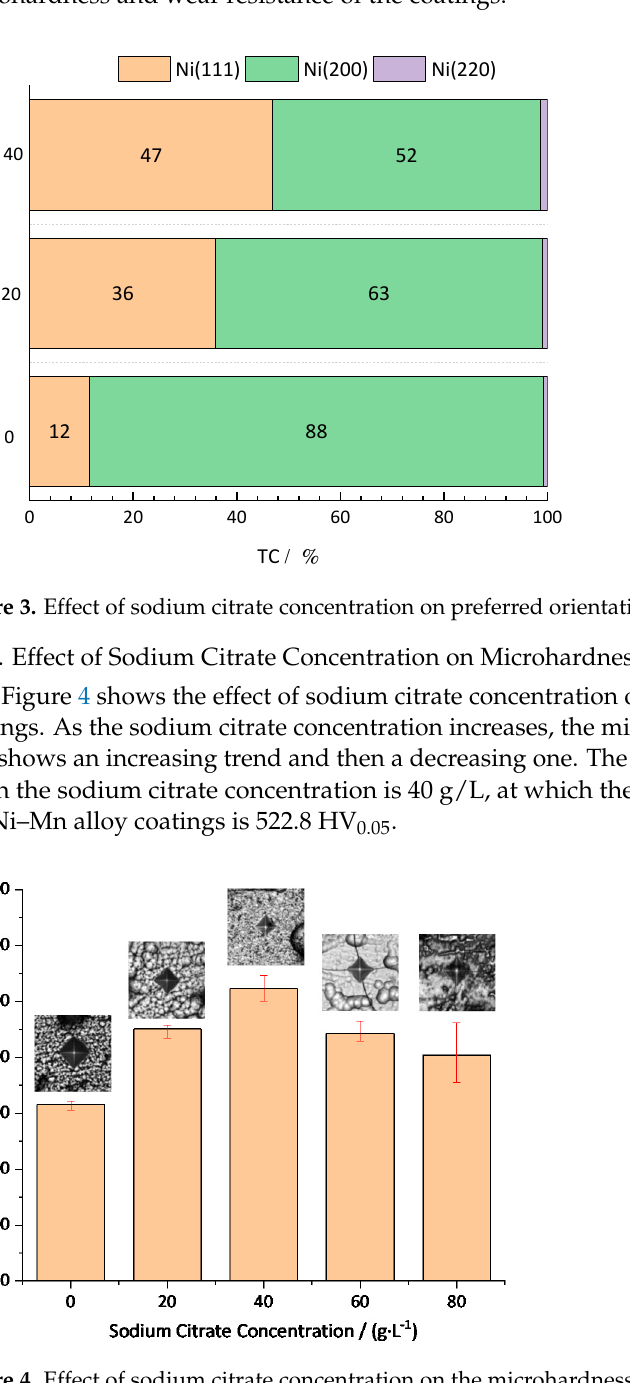
Figure 4. Effect of sodium citrate concentration on the microhardness of coatings.